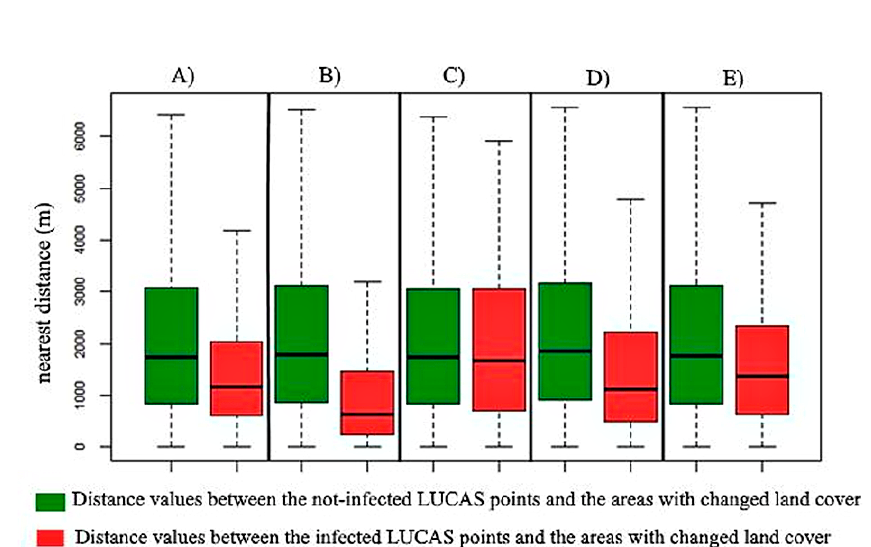
Figure 2. The distribution of Euclidean distances between the uninfected LUCAS points and the changed land cover areas. The distribution of Euclidean distances between the infected points and the changed land cover areas of